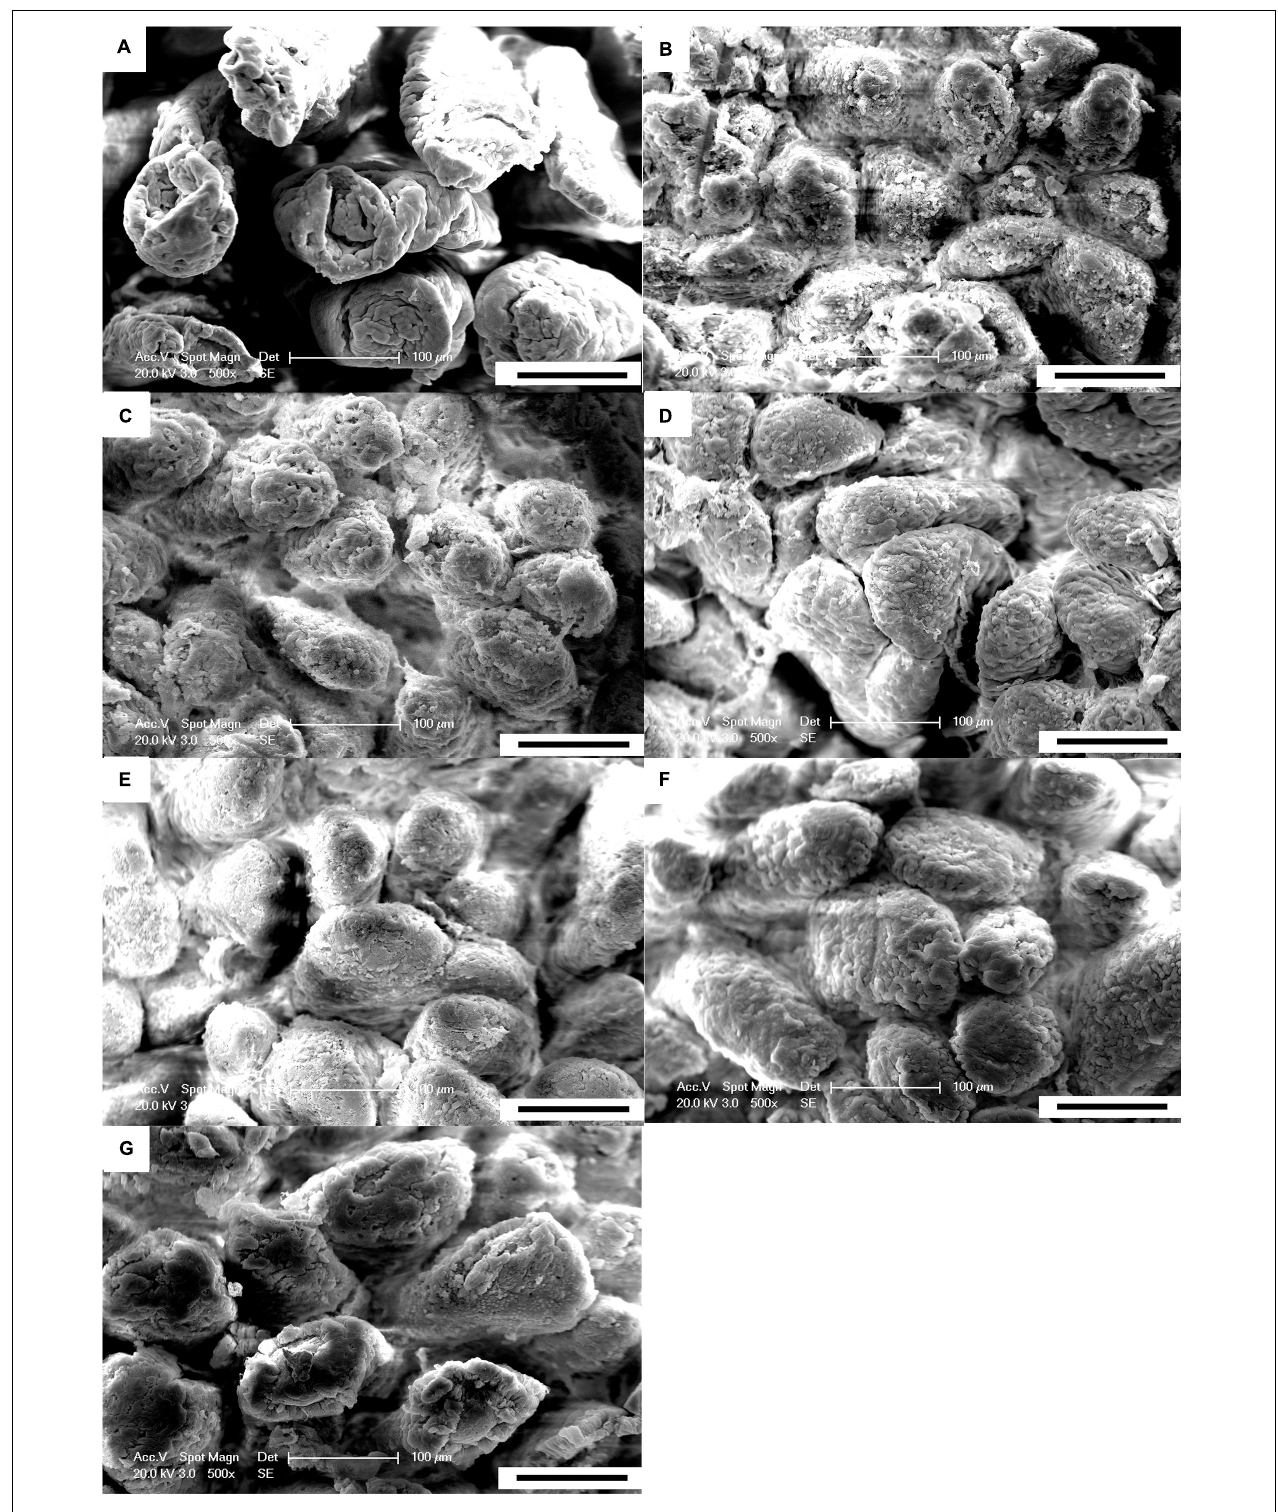
FIGURE 1 | Scanning electron microscopy of the small intestine of weaned piglets (500 × ). (A–G) indicate the CON, ANT, ZO, NZO, LPNZ, MPNZ, and HPNZ groups, respectively. (A–G) show the villi magnified 500 times under a scanning electron microscope. The CON group has damaged, shorter and jagged intestinal villi in comparison with the PNZ group (A,E–G) . The integrity of the villi from the PNZ is greater than that of the ANT and NZO (B,D) . The villi structure of ZO is similar to that of PNZ (C) .